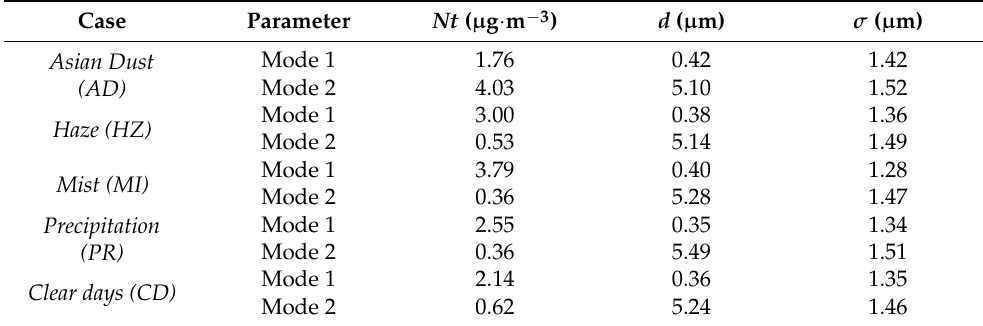
Table 4. Lognormal fit parameters to the mass concentration distribution for each case, where Nt is the total aerosol mass concentration, d is the geometric mean diameter, and σ is the geometric standard deviation.